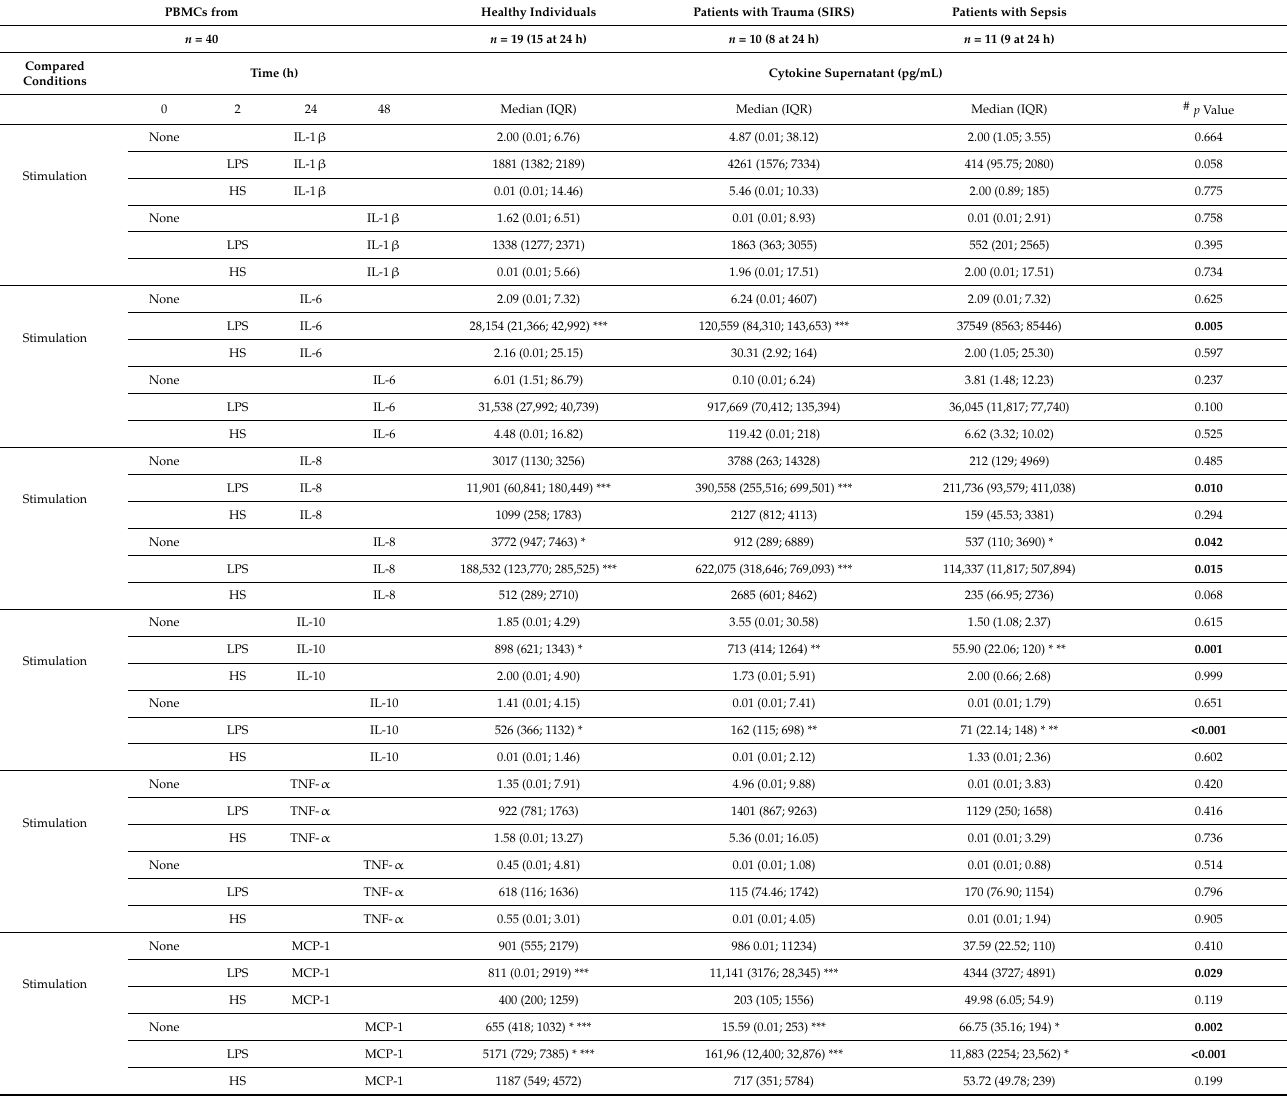
Table 5. Comparison analysis of supernatant cytokine concentrations among different stimulation conditions in patients with sepsis or trauma, and healthy